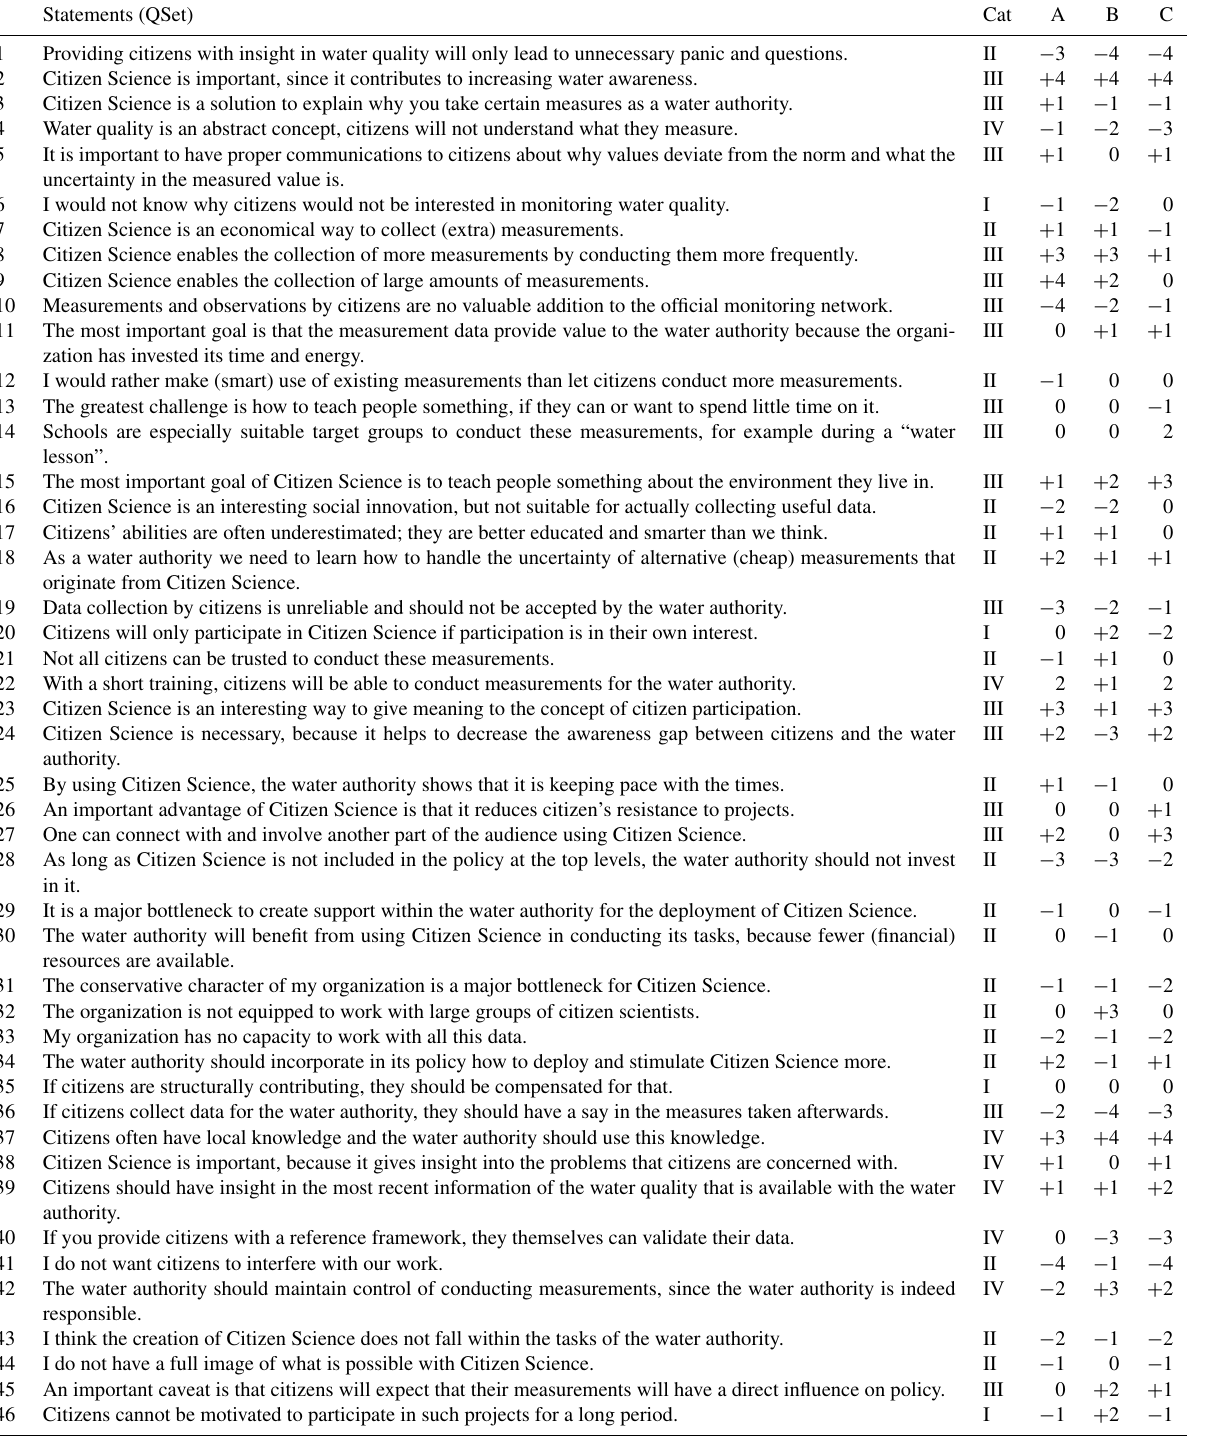
Table 1. Final factor arrays; the numbers in columns A, B and C are the theoretical item score for a person whose viewpoint is 100% that factor. Roman numerals indicate the theme category (cat) of the item. I is citizen motivation, II is water authority acceptance of citizen science, III is purposes, and IV is level of